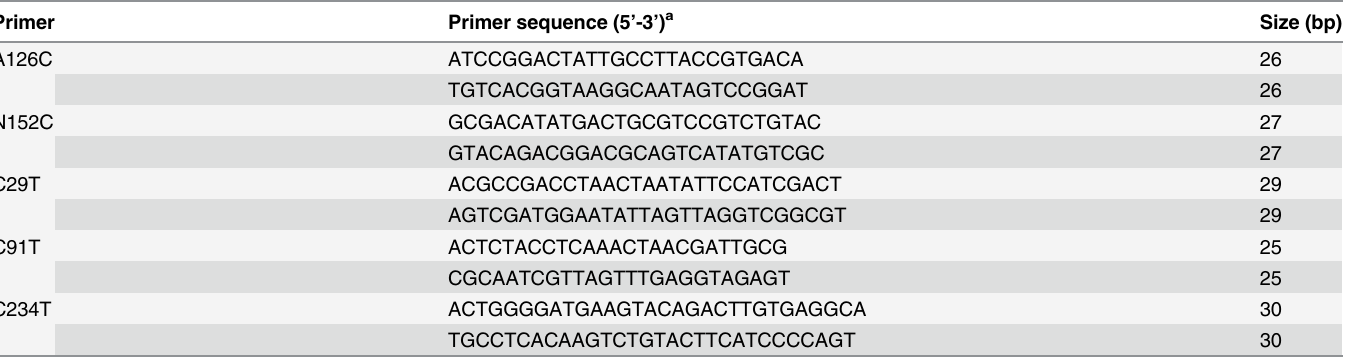
Table 1. Primers used for site-directed